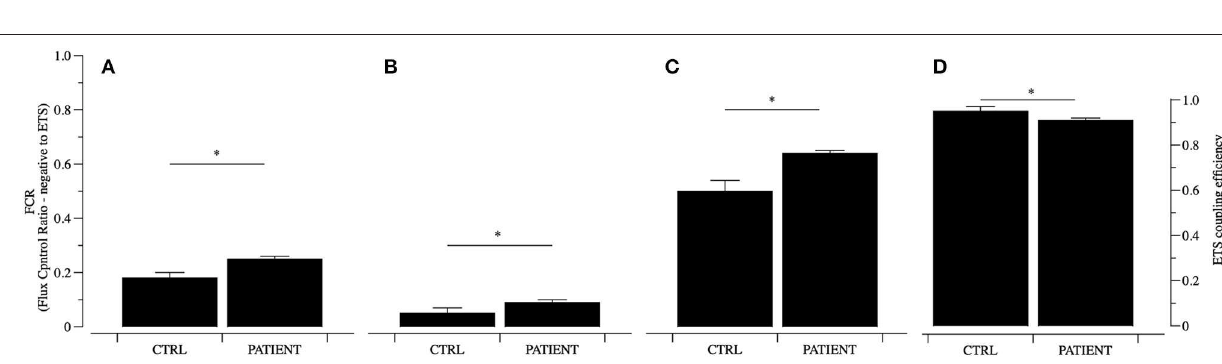
FIGURE 2 | Mitochondrial function analyzed in permeabilized PBMCs. Mitochondrial function was analyzed using a substrate inhibitor titration (SUIT) protocol and data of Flux Control Ratio (FCR) relative to ETS are reported for controls (CTRL) and PATIENT. The ROUTINE (A) , LEAK (B) , OXPHOS cI (PM, C ), respiratory states and ETS coupling efficiency (1-L/E, D ) were analyzed. Data are represented as mean ± SD. * P <